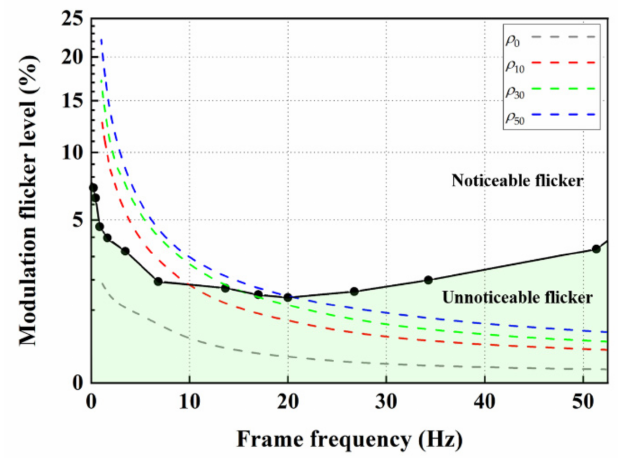
Figure 8. Frequency-dependent modulation flicker levels of the FFS n -LC modes (fullerene doping density within the high- ρ PI: 0.05 wt%) according to the photocontrolled resistivity conditions, where ρ 0 , ρ 10 , ρ 30 , and ρ 50 correspond to the photocontrolled PI resistivity levels, obtained under the Ar laser irradiation intensity conditions of 0 mW · cm − 2 , 10 mW · cm − 2 , 30 mW · cm − 2 , and 50 mW · cm − 2 , respectively. The black solid line with the symbols represents the frequency-dependent modulation flicker threshold curve, extracted from